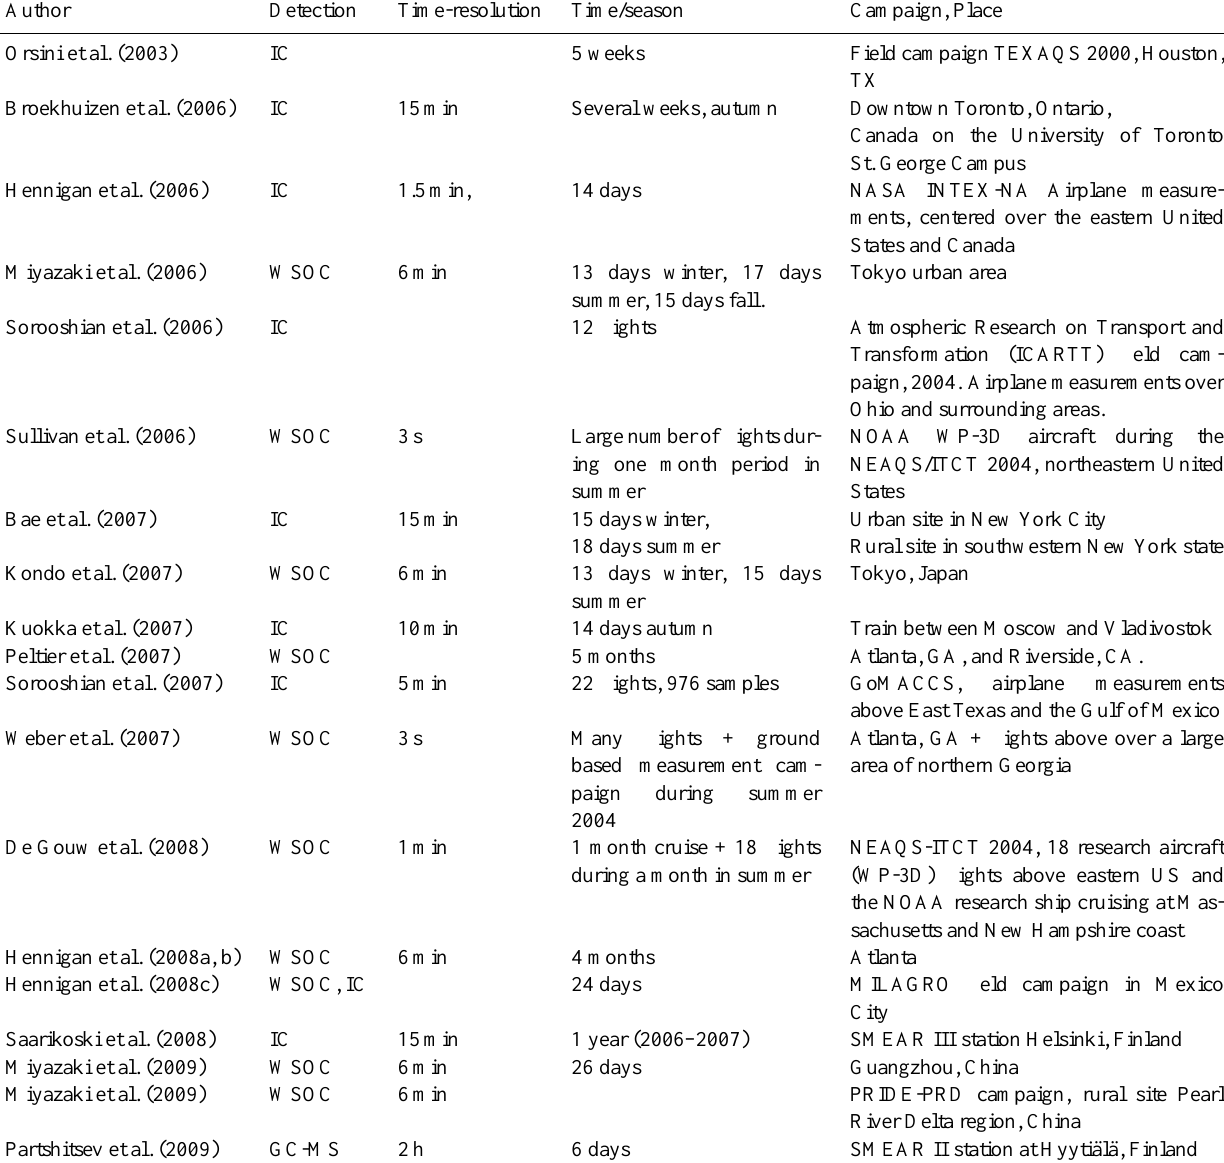
Table 1. Main PILS-measurement campaigns reported in the